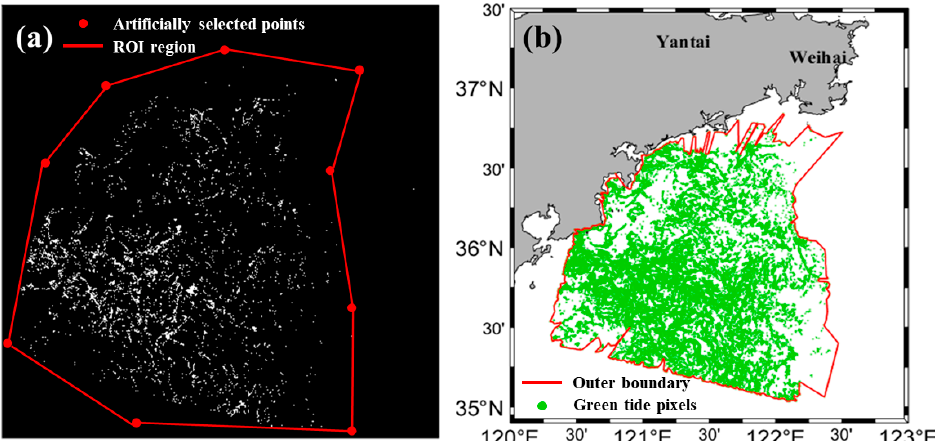
Figure 4. Threshold segmentation separating the seawater and green tide binarized images, ( a ) is the binarized green tide information and ( b ) is the extraction result of green tide, the outer boundary red line is indicated to the distribution of green tide. The data were extracted from Landsat 8 (Date: 23 June 2021; Worldwide Reference System: path 119 and row 35).